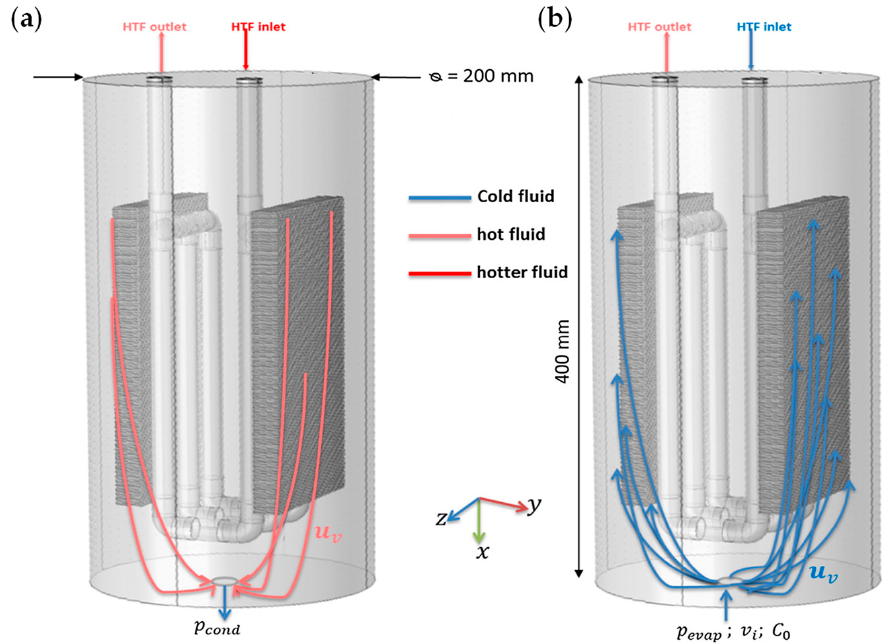
Figure 24. Reactor geometry model in ( a ) charging phase and ( b ) discharging phase for simulations [259]: Reprinted with permission from Ref. [259] Copyright © 2015 Elsevier Ltd. All rights reserved.